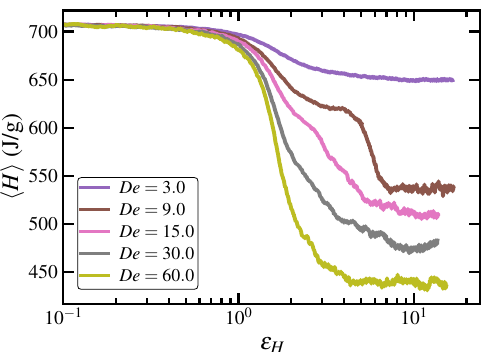
Figure 10. Transient ensemble-averaged enthalpy vs. Hencky strain upon startup of UEF of the PE melt at selected values of De . The precipitous drop of enthalpy at ε H the steep increase of q , as depicted in Figure 8a, which underscores the onset of FIC at this value of Hencky strain.